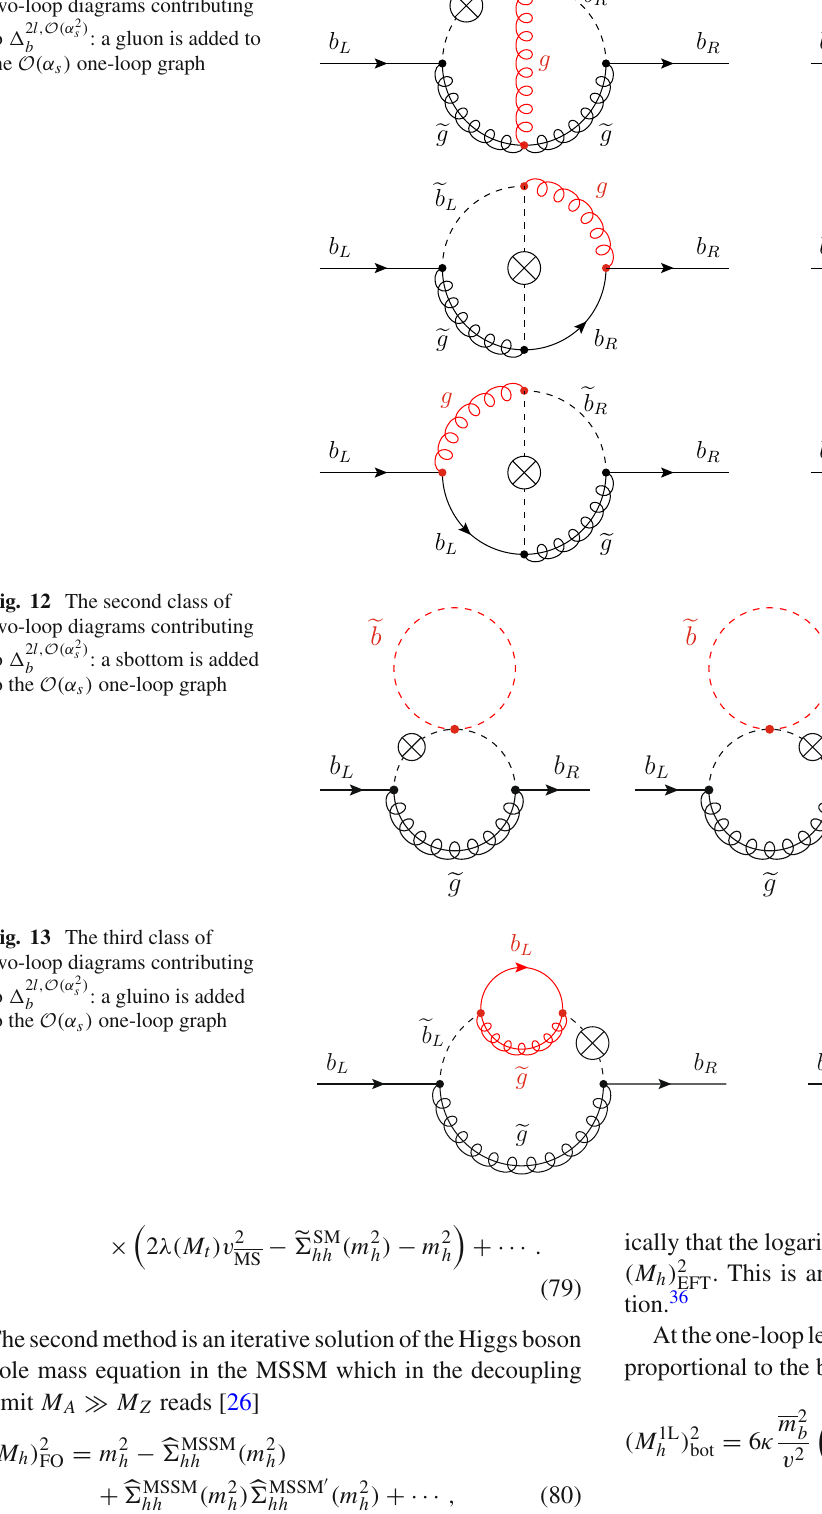
Fig. 11 The first class of two-loop diagrams contributing